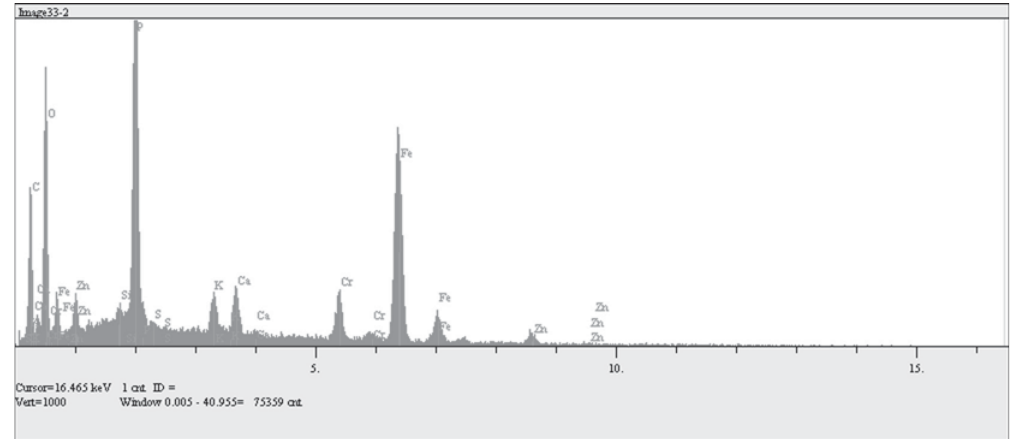
Figure 2- Quantitative energy dispersive x-ray spectroscopy (EDS) reading representative of areas of color change suggestive of corrosion in the soldered region in contact with the band and the wire in a Group I specimen